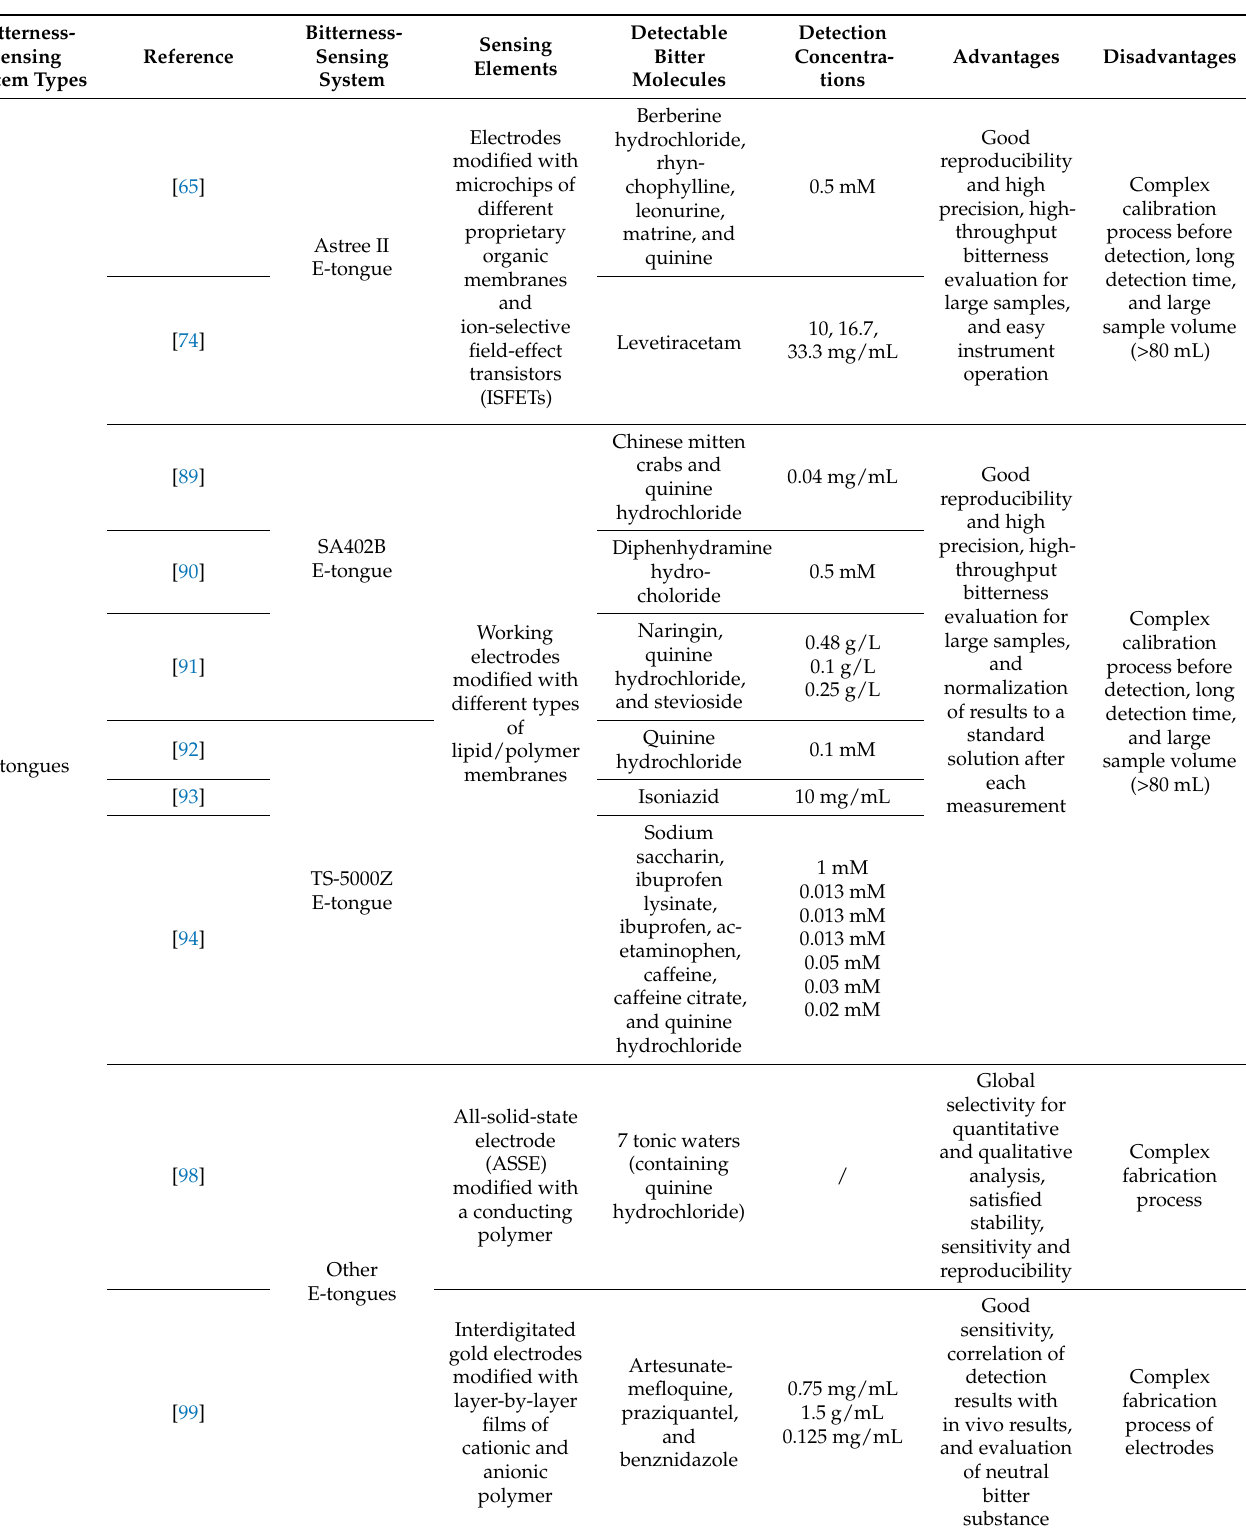
Table 1. Comparison of bitterness-sensing systems based on modified electrodes and